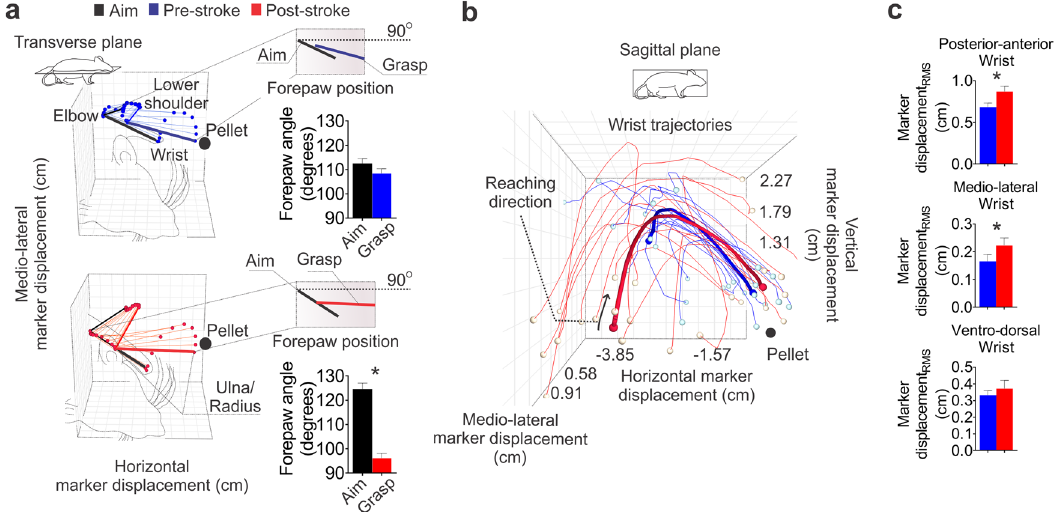
Figure 6. Abnormal wrist trajectories following stroke. ( a ) Pre-stroke aiming position closely resembles final grasping position, while post-stroke aiming and grasping positions are different (aim position: black line grasp position: colored line). ( b , c ) There was increased posterior-anterior and medio-lateral wrist joint movements, while no differences were apparent in the ventro-dorsal plane. Mean traces (thick lines) and individual traces (thin lines). Mean stick figures (n = 13). Paired t-test, * p < 0.05, mean ±